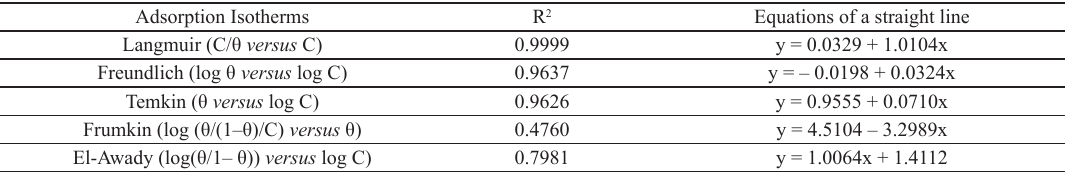
Table 7. Parameters obtained for different adsorption isotherms. Adsorption Isotherms R 2 Equations of a straight